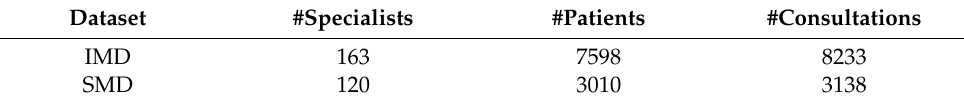
Table 3. Data Statistics.